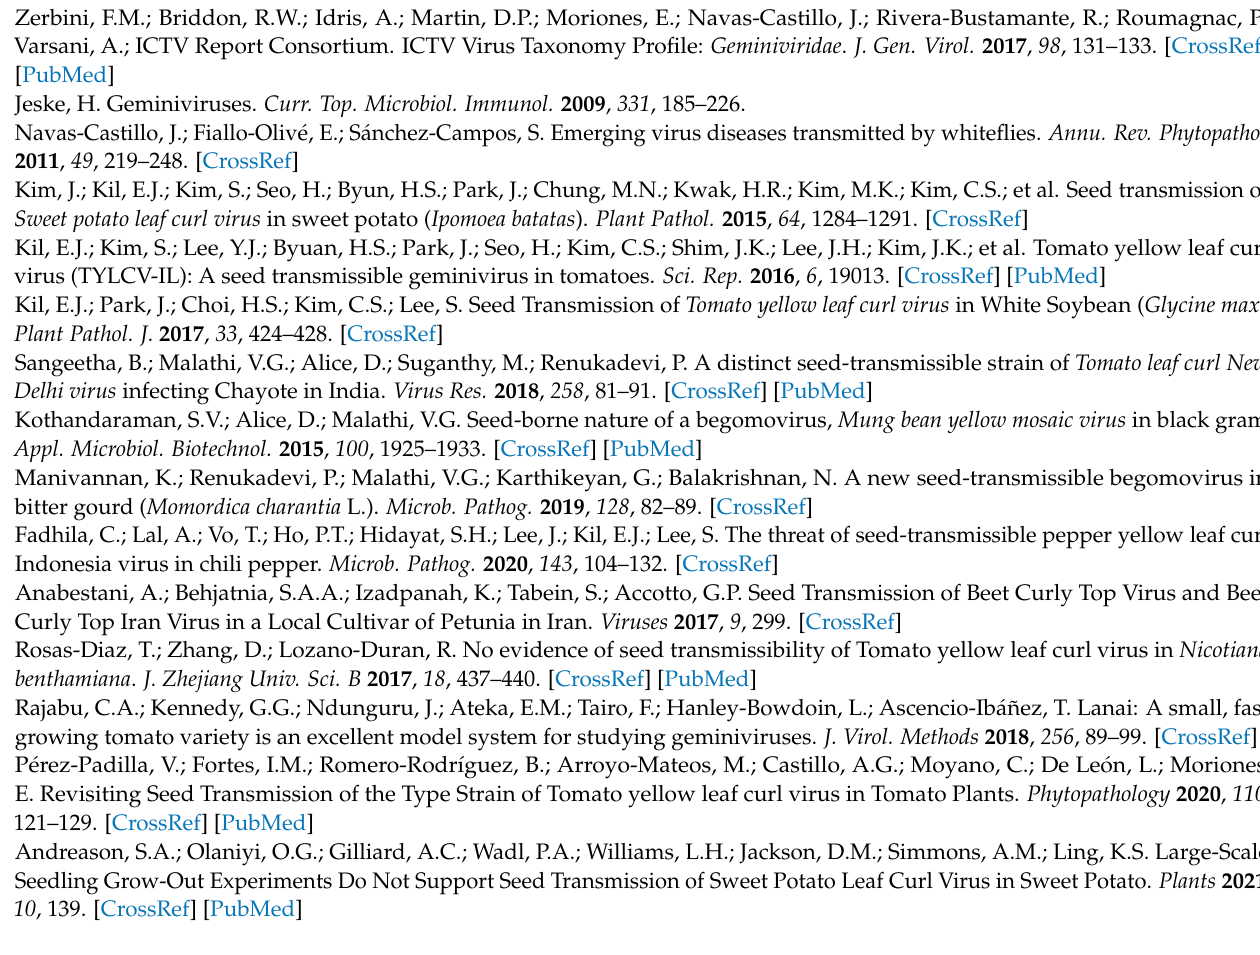
Table S1: Raw data relative to the quantification of TYLCSV DNA by qPCR in tissues derived from different plant